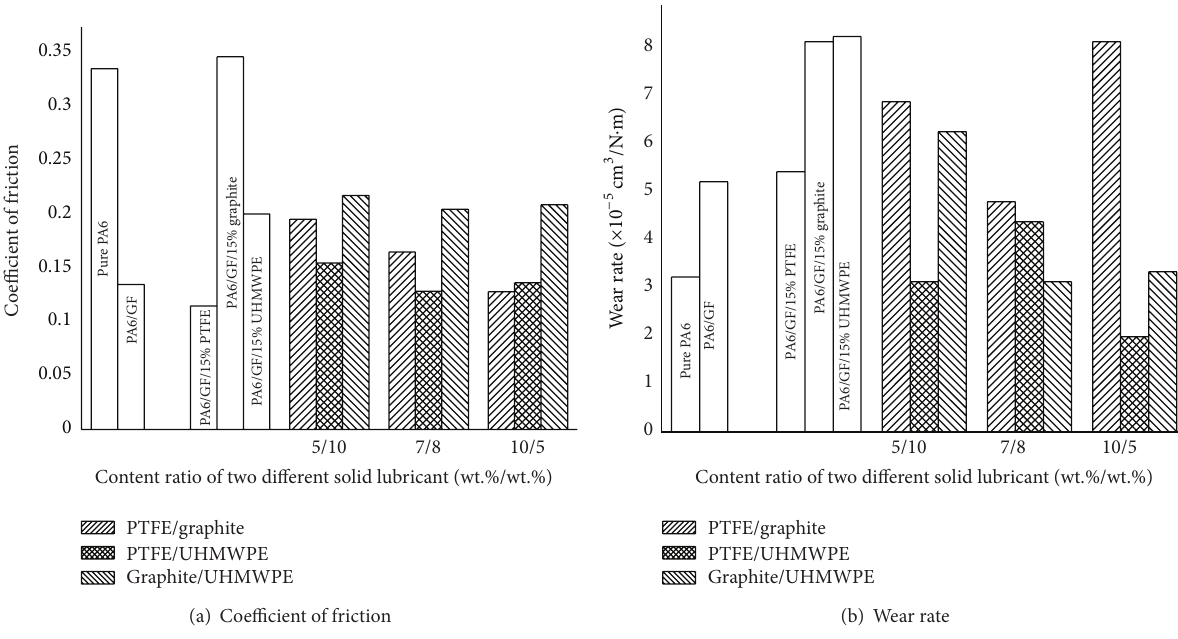
Figure 4: Friction and wear behaviors of PA6/GF composite filled with complex solid